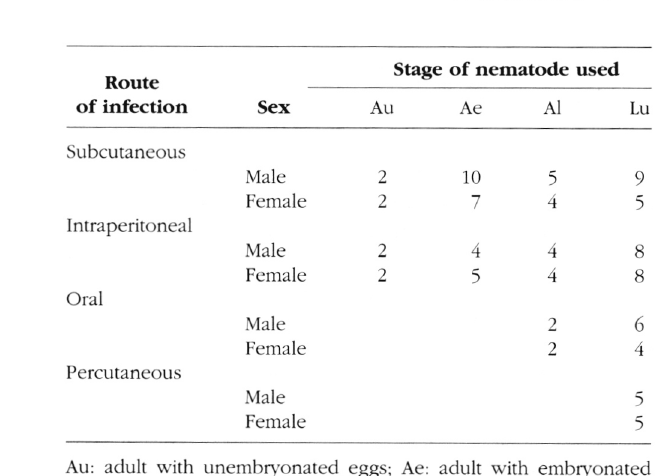
Table II. - Numbers of BALB/c mice used to determine stage of Mus- picea borreli and route of administration to achieve experimental infection of mice.